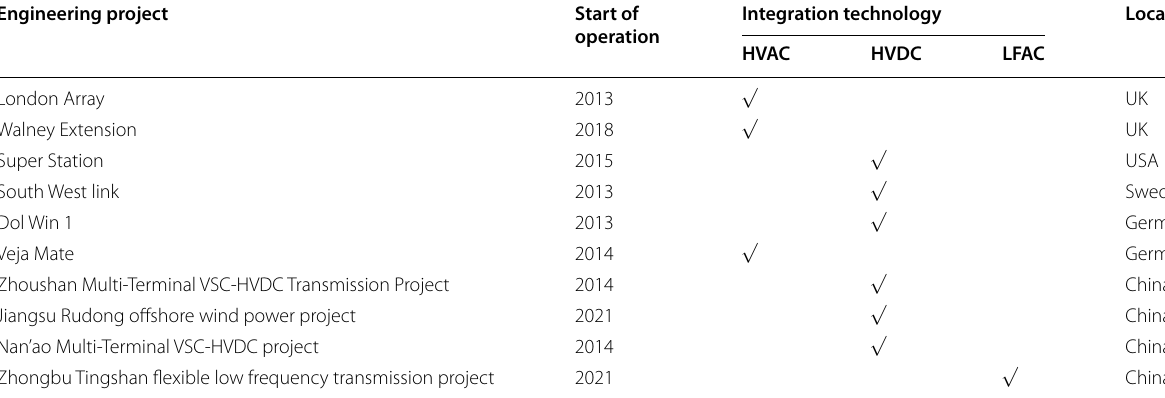
Table 12 Engineering examples about integration technology Engineering